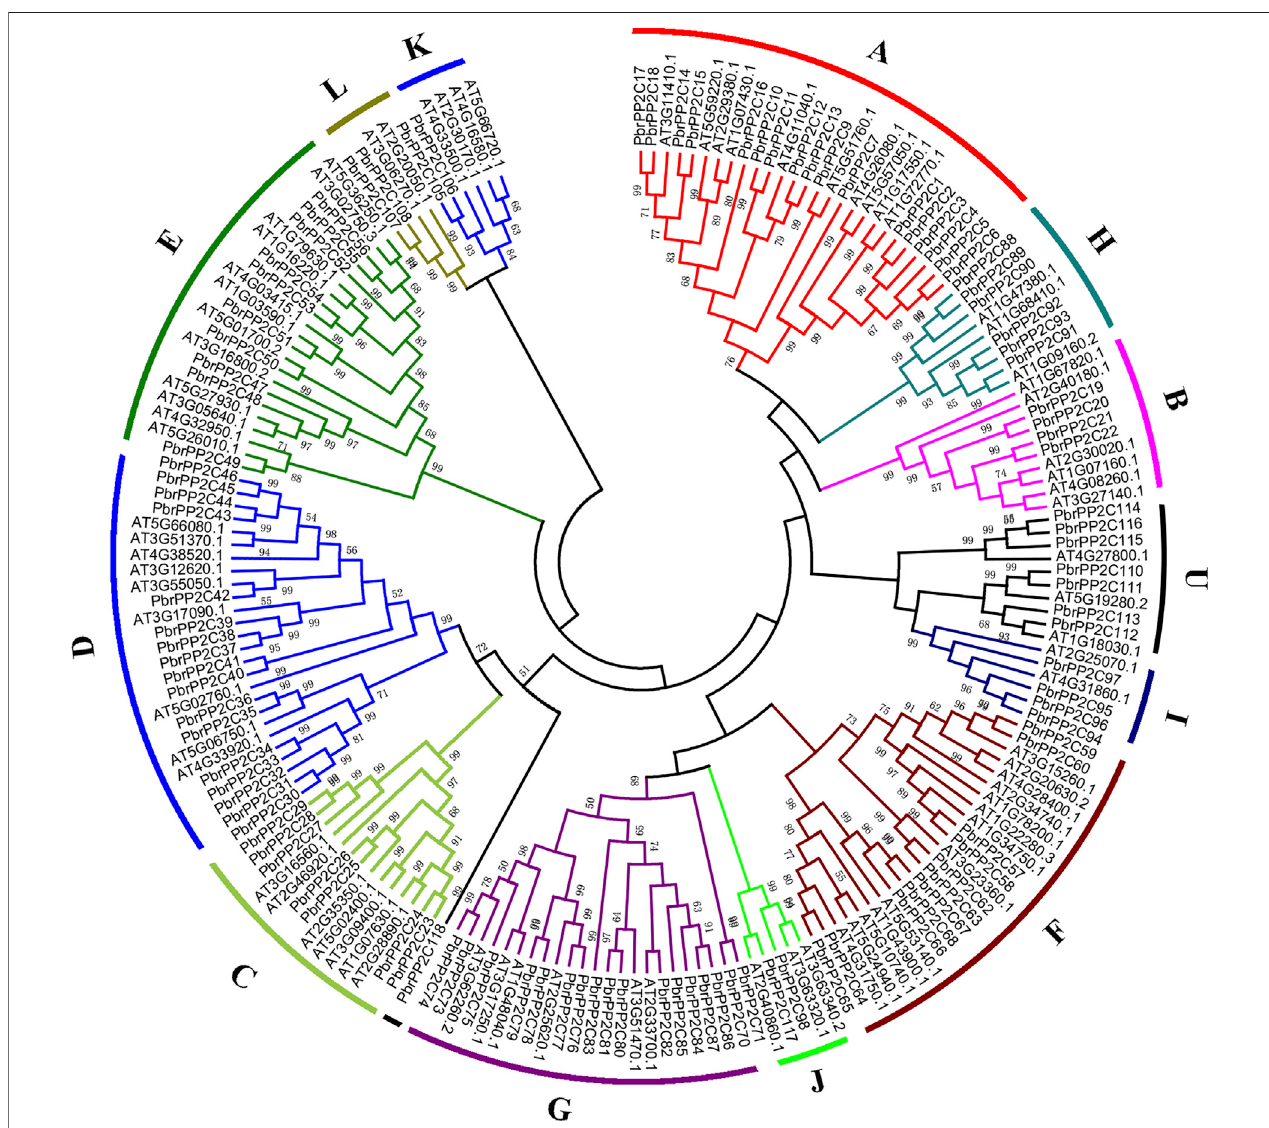
FIGURE 1 | Phylogenetic analysis of the PbrPP2C family in both Chinese white pear and Arabidopsis . Phylogenetic tree was constructed using the maximum likelihood method.